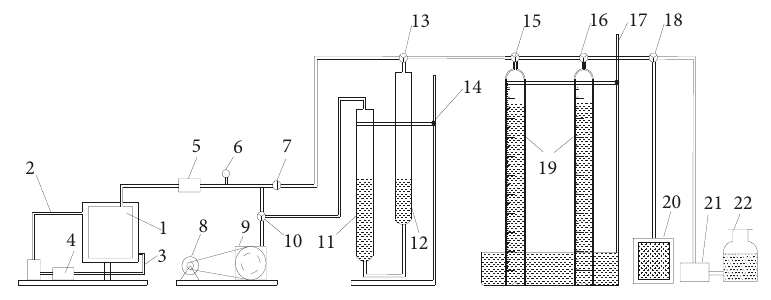
Figure 3: Desorption device in underground.